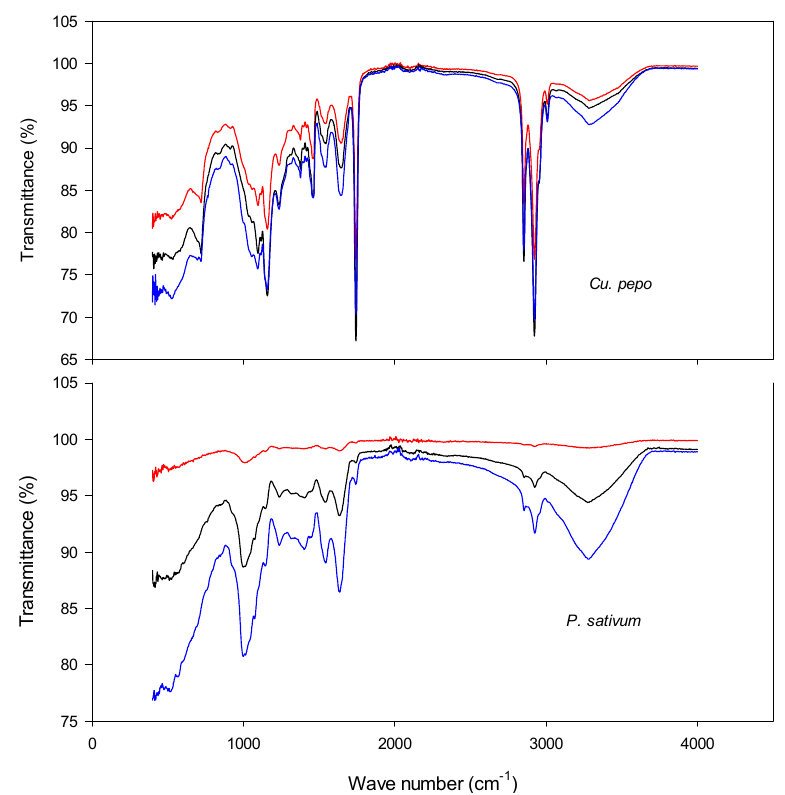
Figure 5. FTIR of Cucurbita pepo and Pisum sativum at 0 (blue), 20 (black), and 32 (red) d of controlled deterioration. Seeds were subjected to controlled deterioration at 40 ° C and 100% relative humidity. Samples were taken at an interval of 4 d intervals, and the samples were subjected to both germination and electrolyte conductivity measurements.